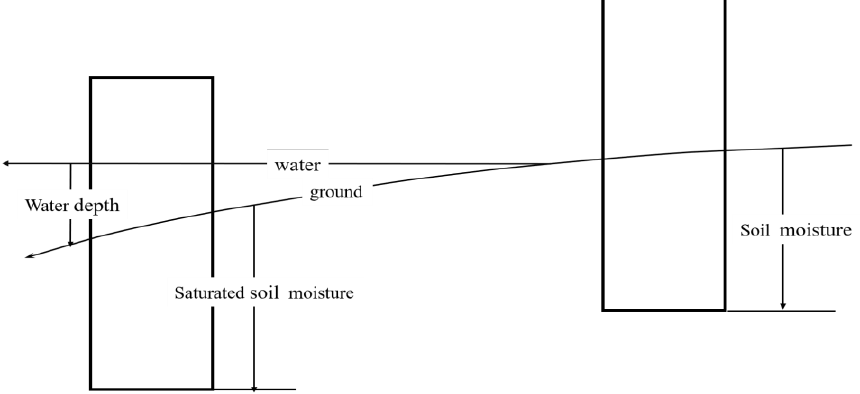
Figure 4. Conversion of the hydrological gradient.